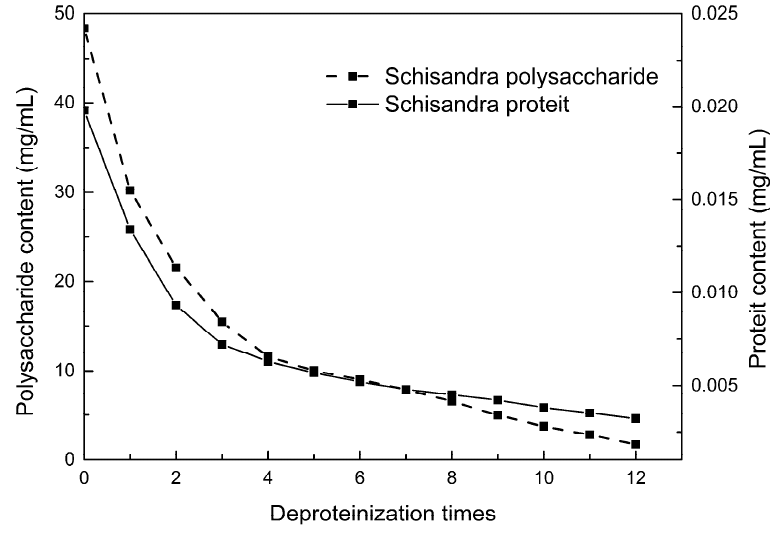
Figure 9. Polysaccharide content after removing protein 12 times with the Sevag method.